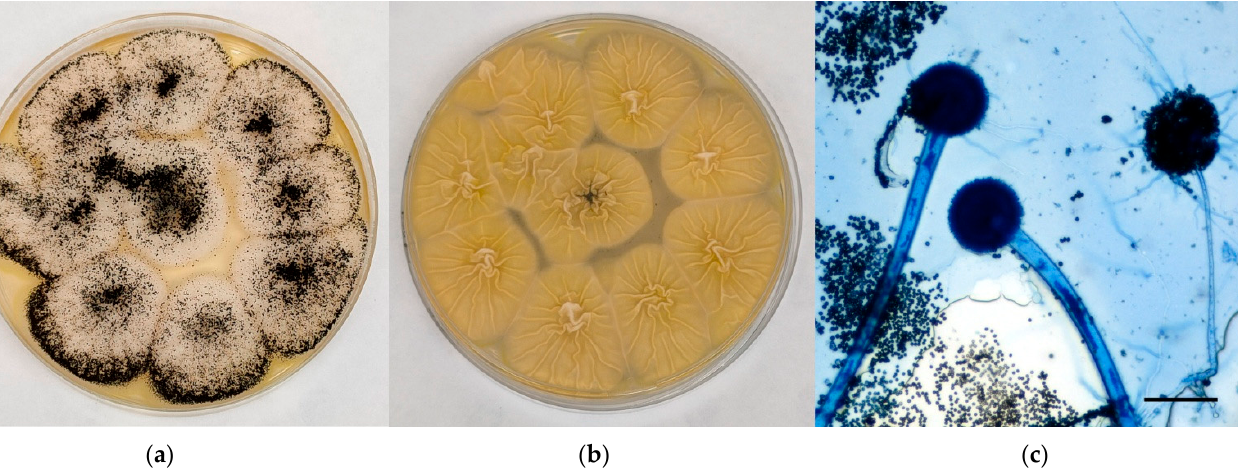
Figure 2. Mycological examination of the colonies referable to A. flavus complex grown onto CZA. ( a ) Macroscopic surface of the colonies; ( b ) Macroscopic reverse of the colonies; ( c ) Microscopic features of the colonies (methylene blue staining, ×40, bar 20 µm).